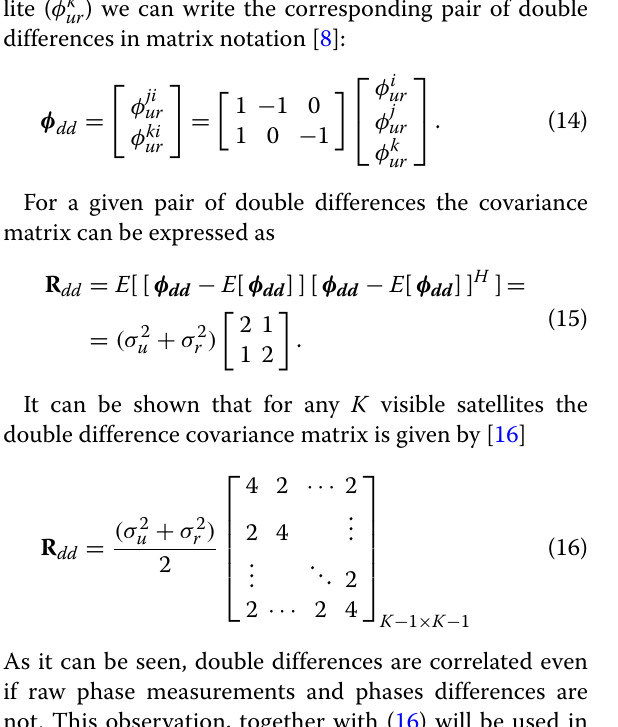
Fig. 4 Geometry of the single difference